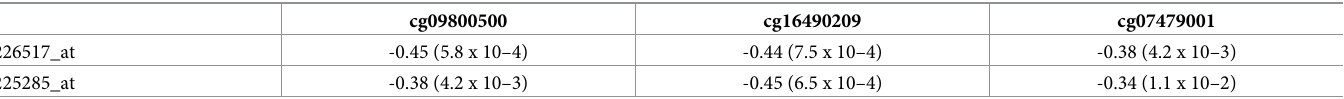
Table 4. Correlation matrix of BCAT1 gene expression and DNA methylation at Illumina CpG sites with p -value shown in